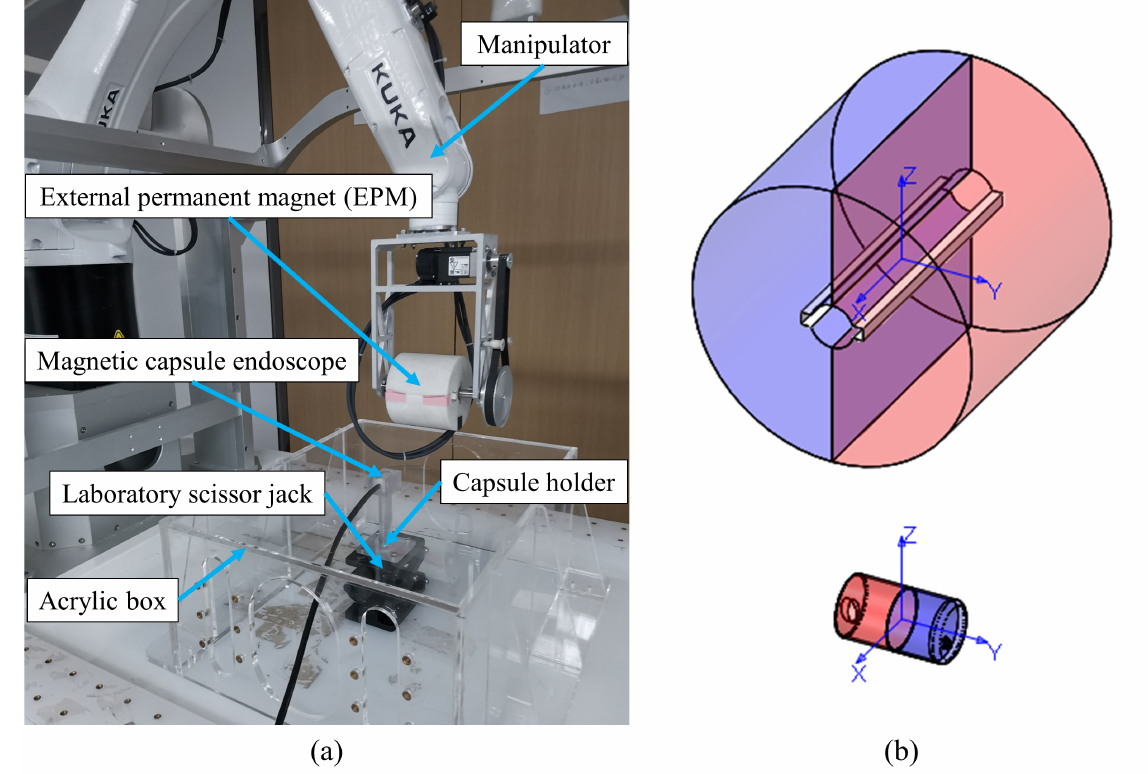
Figure 6. The platform used to recognize the motion status of the magnetic capsule endoscope. ( a ): Experiment platform. ( b ): Local coordinate systems of the EPM and the magnetic